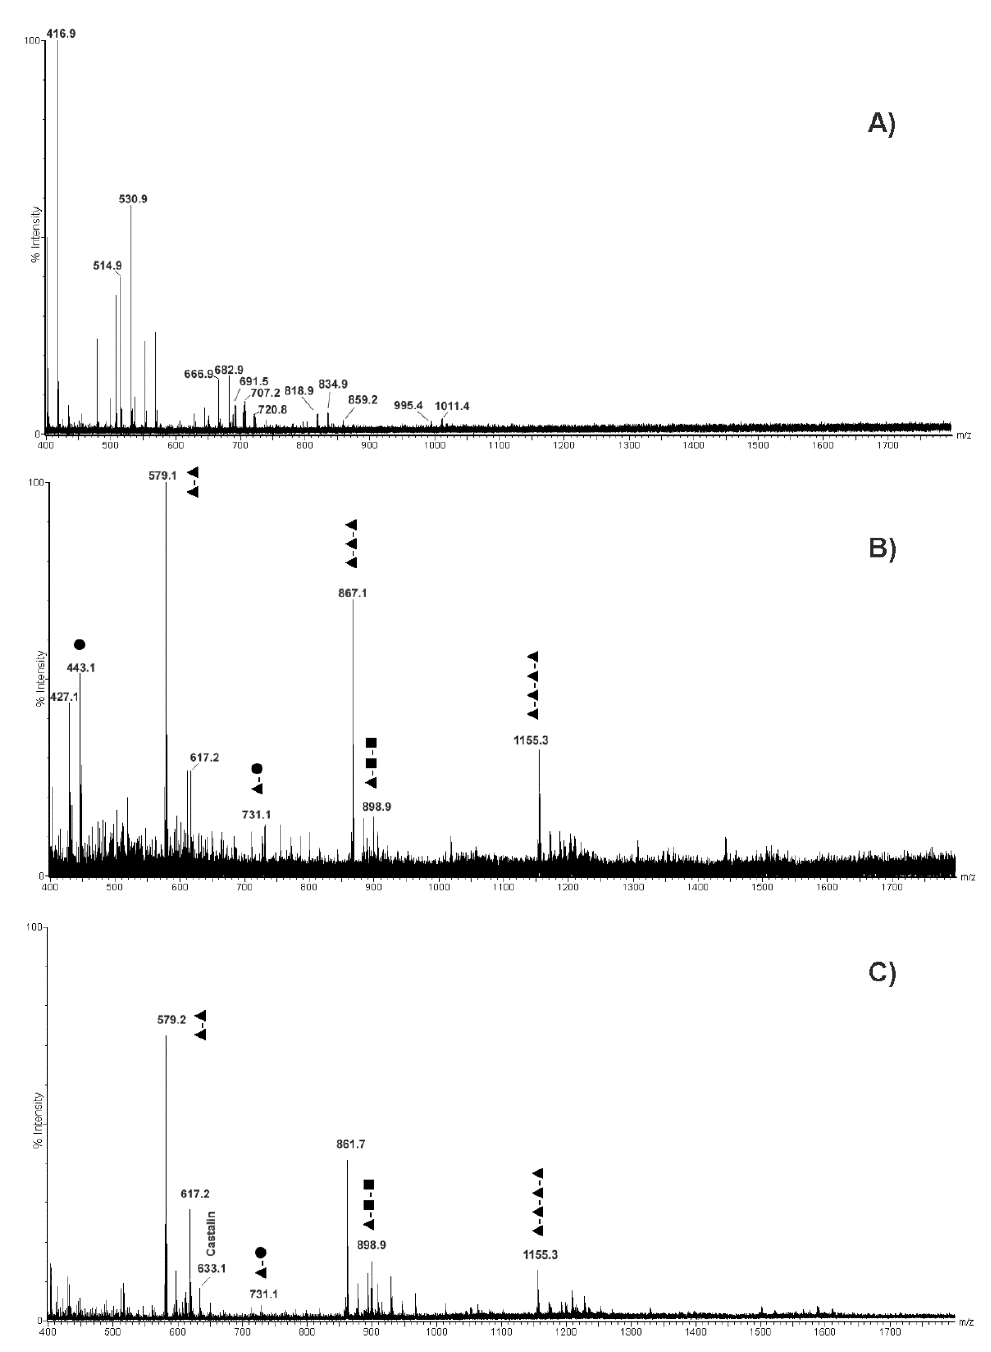
Figure 7. MS spectra of the polyphenol compounds recorded in positive ion mode occurring in the wastewater samples recovered at the end of three curing assays: ( A ) water containing cultured Lb. pentosus ; ( B ) tap water; ( C ) recycled wastewater.